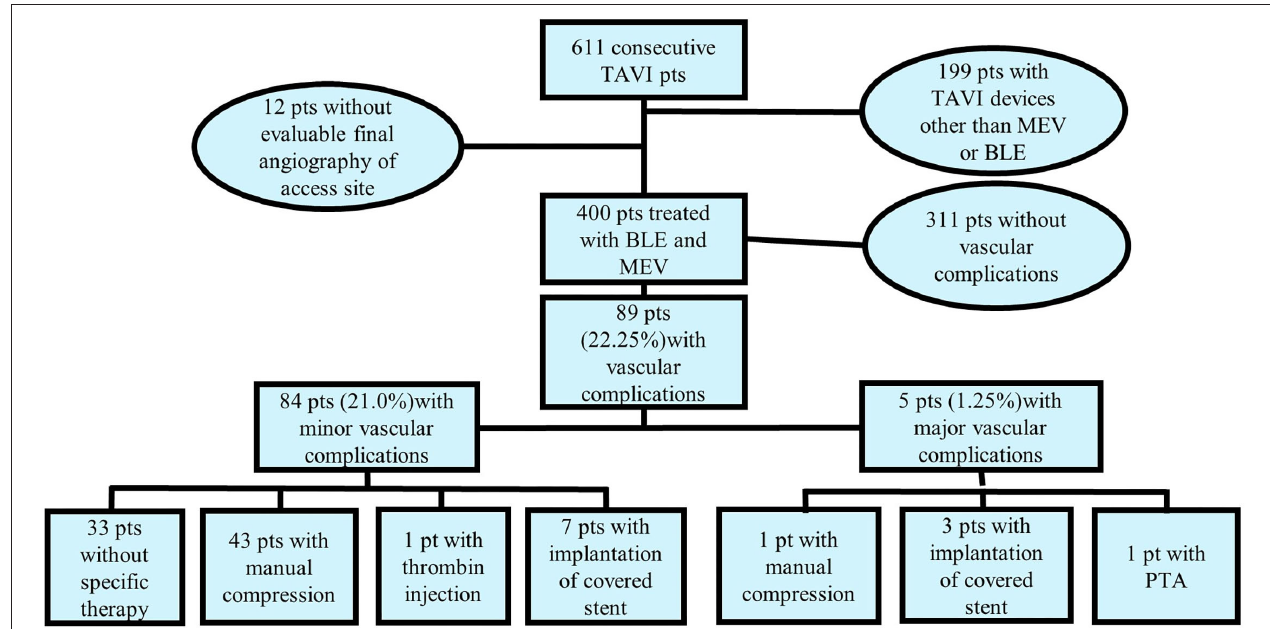
FIGURE 3 | Treatments for patients with minor and major access site vascular